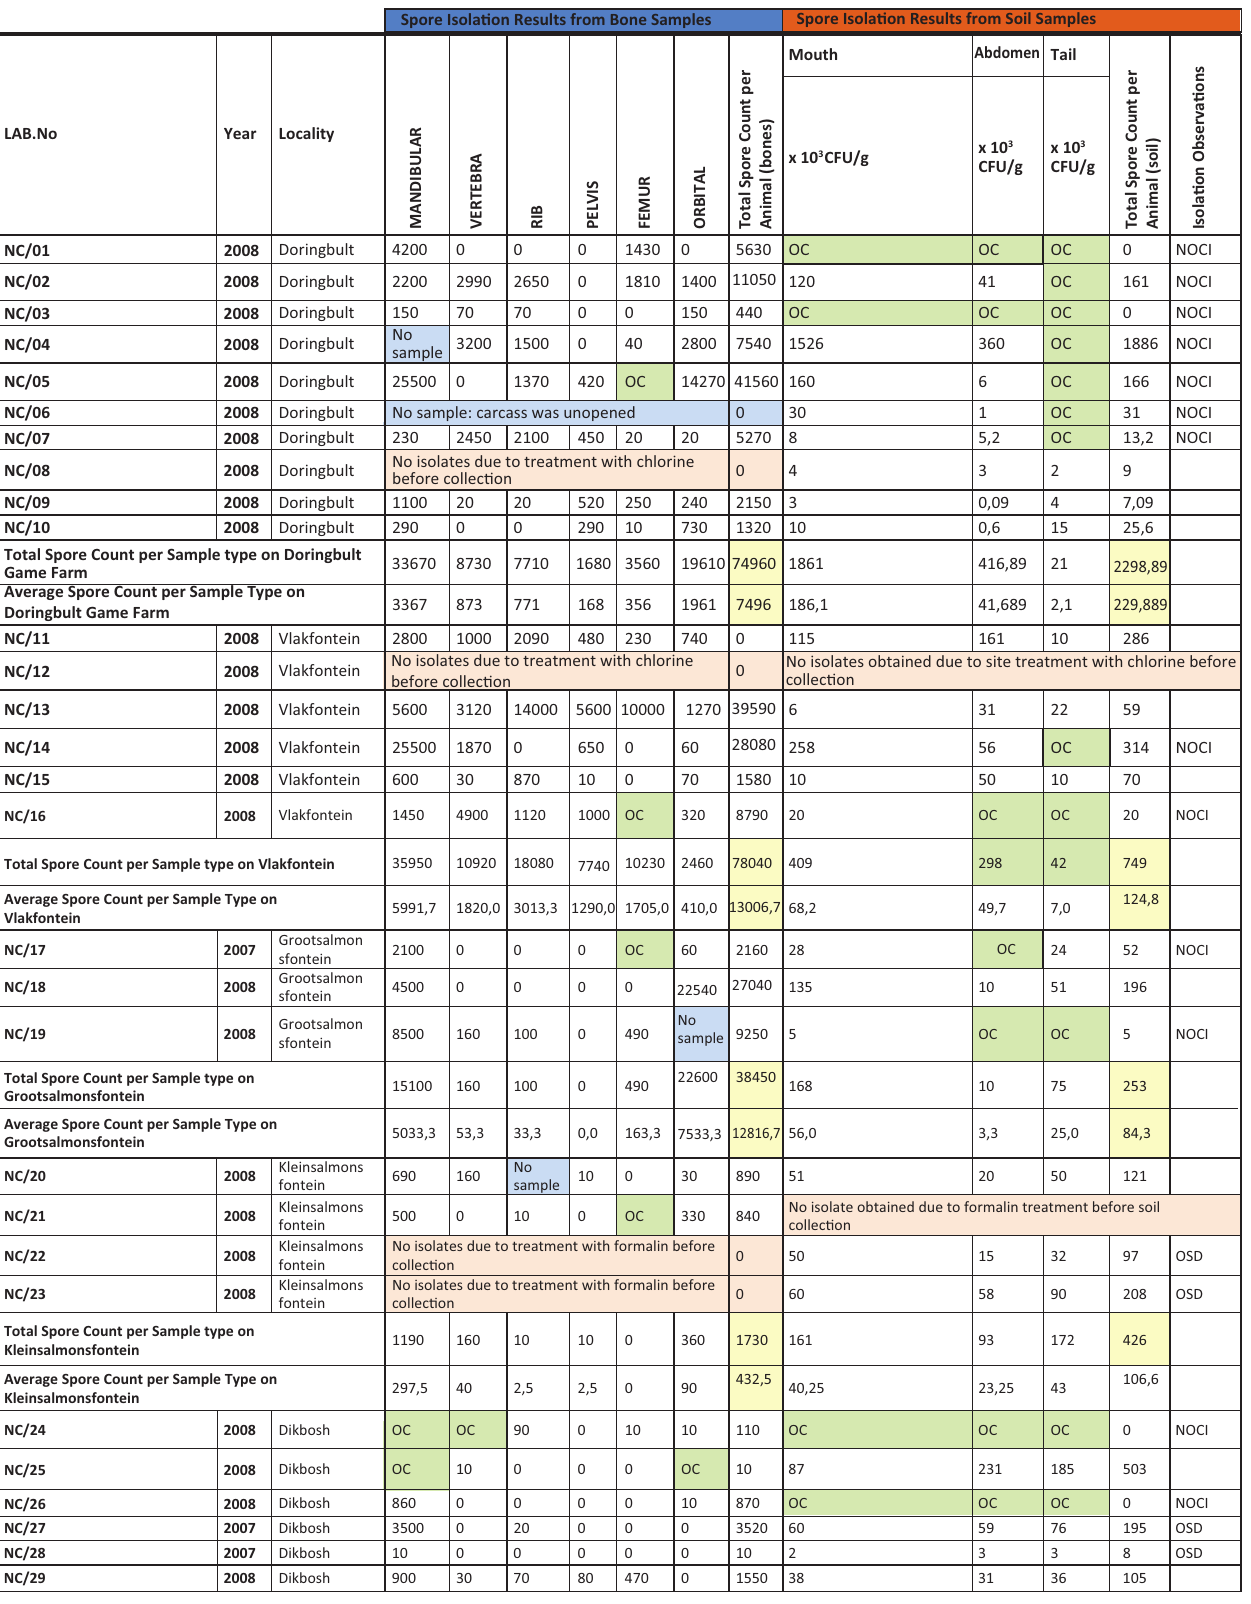
Spore Isola(cid:21)on Results from Bone Samples Spore Isola(cid:21)on Results from Soil Samples